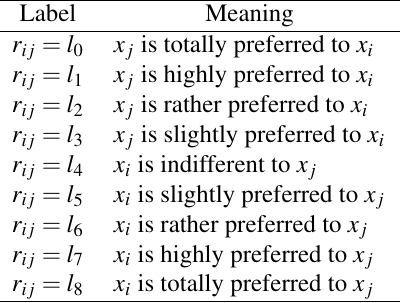
Table 3. Meaning of the linguistic